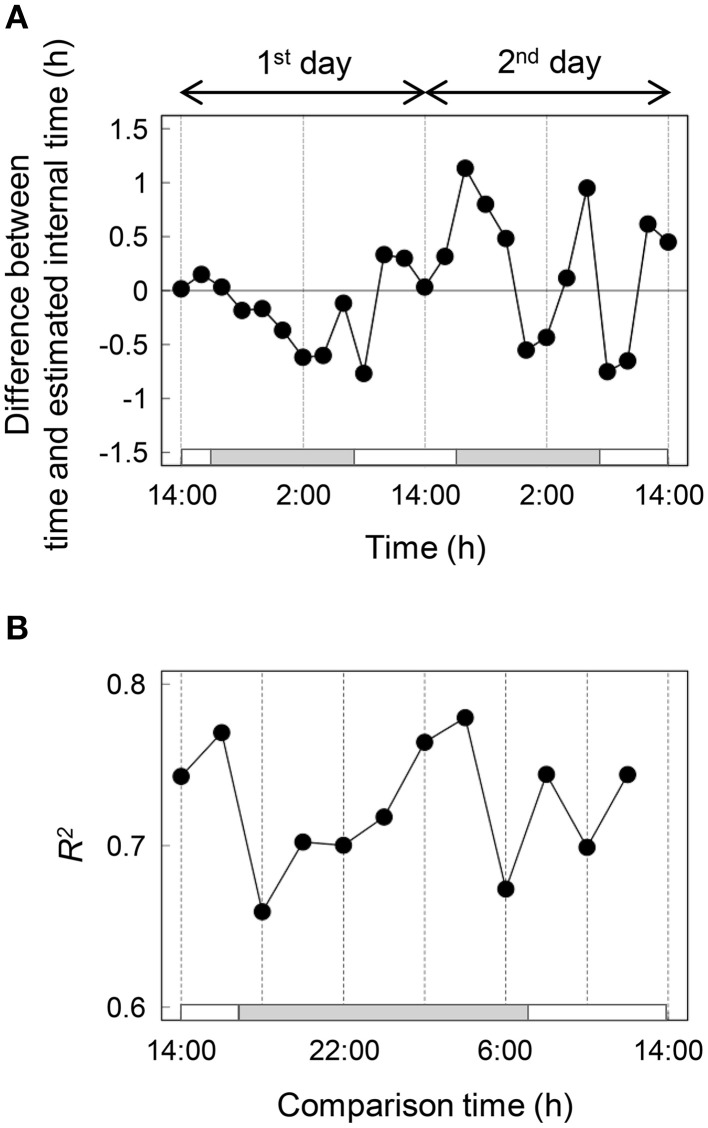
Validation of the internal time estimation (A) and transition of the determination coefficient between normalized expression levels for the 1st and 2nd days (B). White and gray bars represent light and dark, respectively.